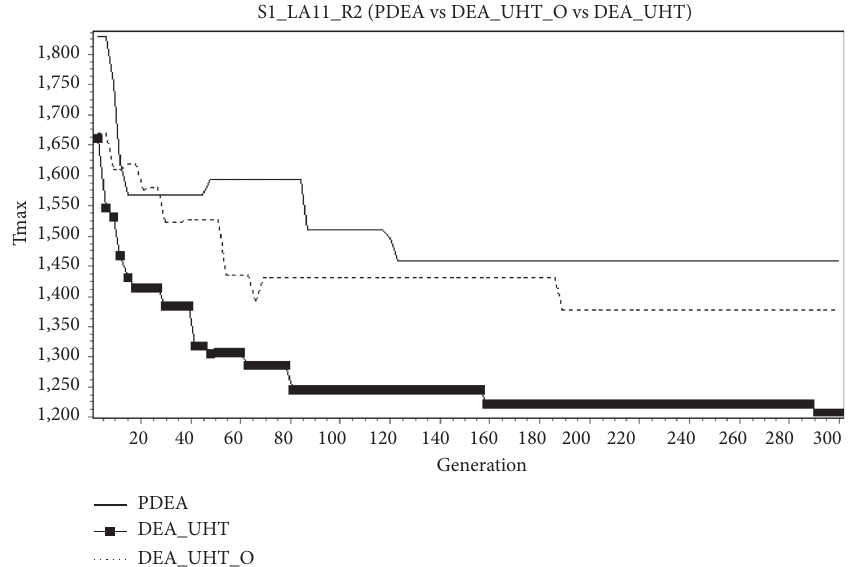
Figure 4: Convergence curves of the compared algorithms on S1_LA11_R2_ T